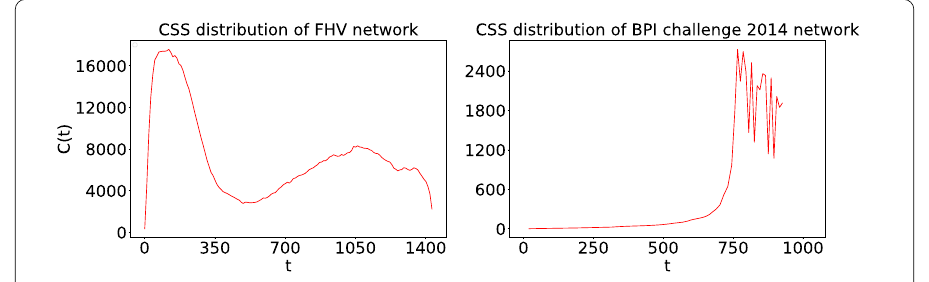
Figure 1 The CSS distribution of some real networks. C ( t ) is the CSS at time t . The FHV CSS (left) can be estimated as a Poisson distribution when t ≤ 480 and a normal distribution in the rest. The BPI CSS (right)